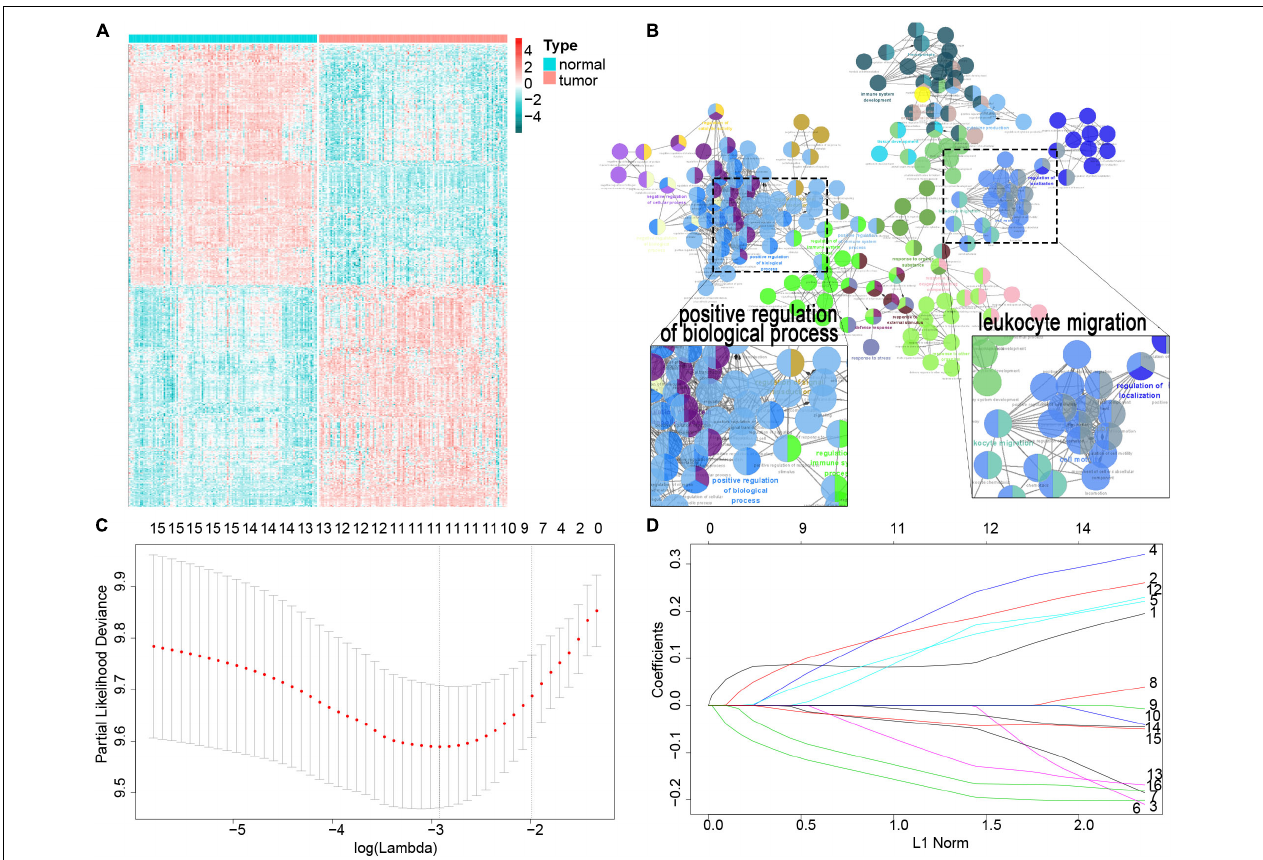
FIGURE 1 | Filter out the most prognostic candidates from the differentially expressed immune-related genes in ESCC. (A) Heatmap of differentially expressed immune-related genes between ESCC and adjacent normal tissues. (B) GO analysis in Cytoscape of these differential genes. (C) One-hundred-fold cross-validation for tuning parameter selection in the LASSO model. (D) LASSO coefficient profiles of the most useful prognostic